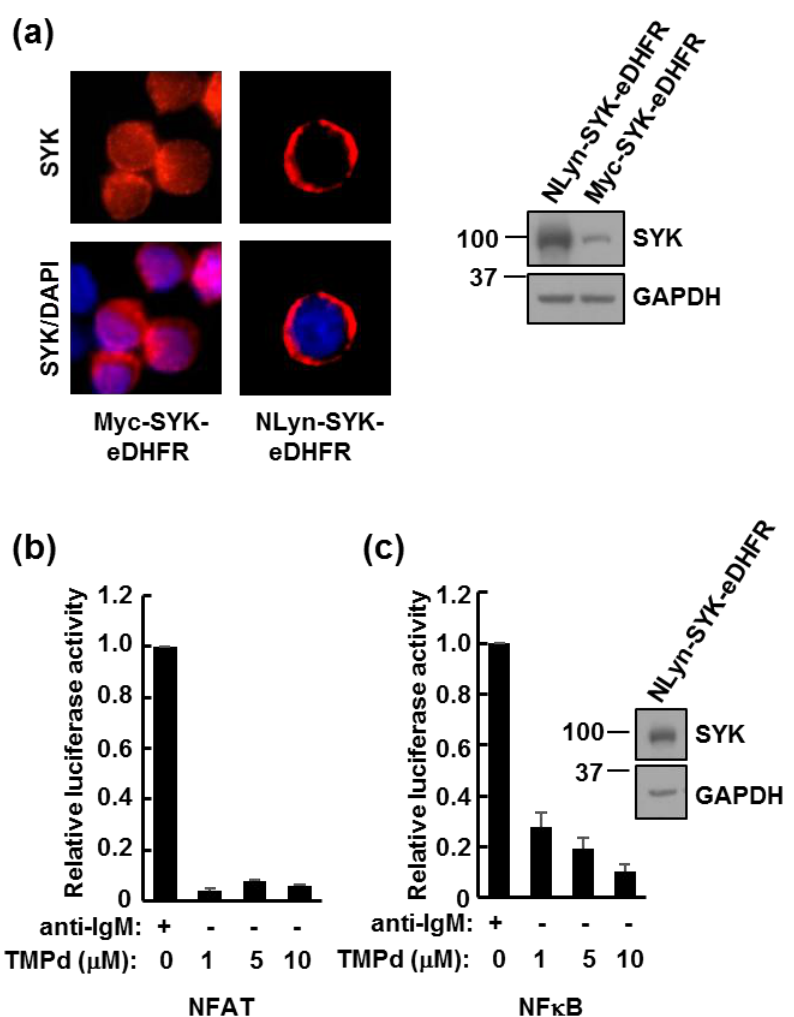
Figure 5. Dimerization of membrane-associated SYK is not sufficient to activate transcription factors. ( a ) SYK-deficient DT40 cells were transiently transfected to express NLyn-SYK-eDHFR or Myc-SYK-eDHFR. Cells were fixed and stained with antibodies against SYK. Nuclei were stained with DAPI. The expression of each protein was verified by Western blotting; ( b , c ) SYK-deficient DT40 cells were transiently transfected with plasmids coding for NLyn-SYK-eDHFR and luciferase reporter plasmids for detecting the activation of either Nuclear Factor of Activated T cells (NFAT) ( b ) or NFκB ( c ). Cells were treated with anti-IgM antibodies to crosslink the BCR or with increasing concentrations of trimethoprim (TMP) dimer (TMPd). Data represent the means ± standard error of the mean (SEM) of triplicate experiments repeated three times. The expression of NLyn-SYK-eDHFR was verified by Western blotting with antibodies against SYK.